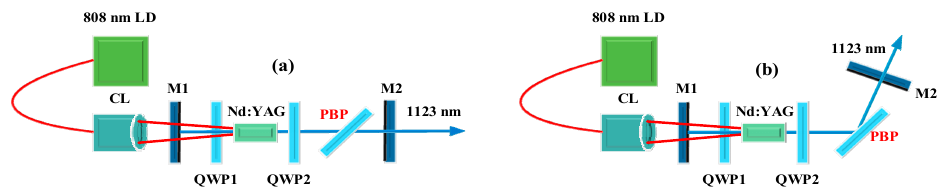
Figure 1. The experimental setup of the single-longitudinal-mode (SLM) 1123 nm lasers, ( a ) linear twisted-mode (TM) cavity, ( b ) L-type TM cavity. LD, laser diode; CL, coupling lens; QWP, quarter wave plate; PBP, polarization beamsplitter plate.